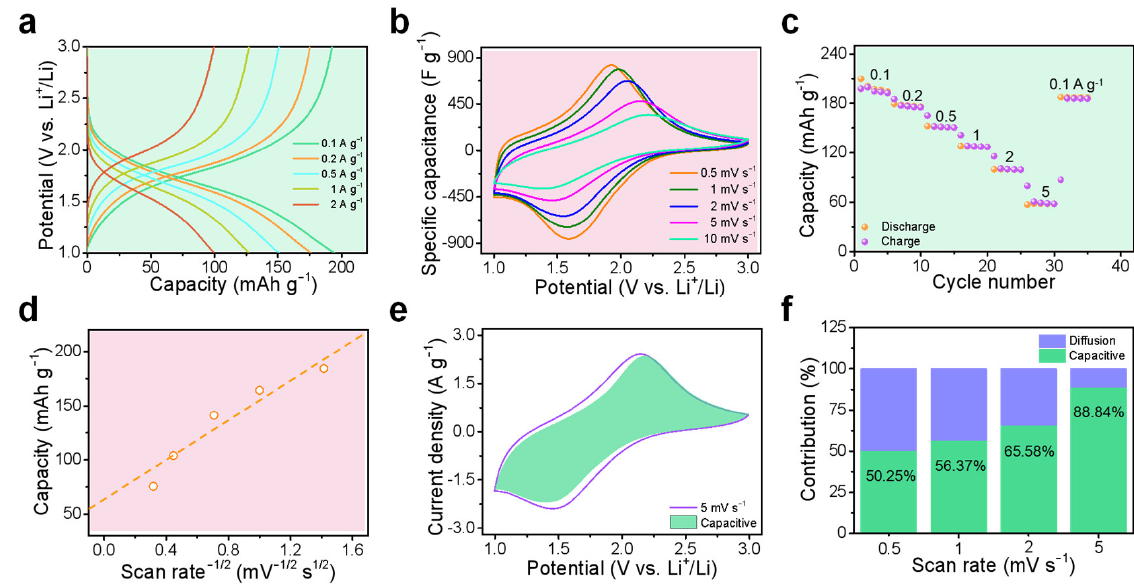
Figure 5. Electrochemical properties of the T−Nb 2 O 5 anode. ( a ) GCD curves at different current densities. ( b ) CV curves at different scan rates. ( c ) Rate performance of the T−Nb 2 O 5 anode. ( d ) Voltammetric capacity. ( e ) CV curve at a scan rate of 5 mV s −1 . ( f ) Contribution of diffusion-controlled charge storage and capacitive charge storage.